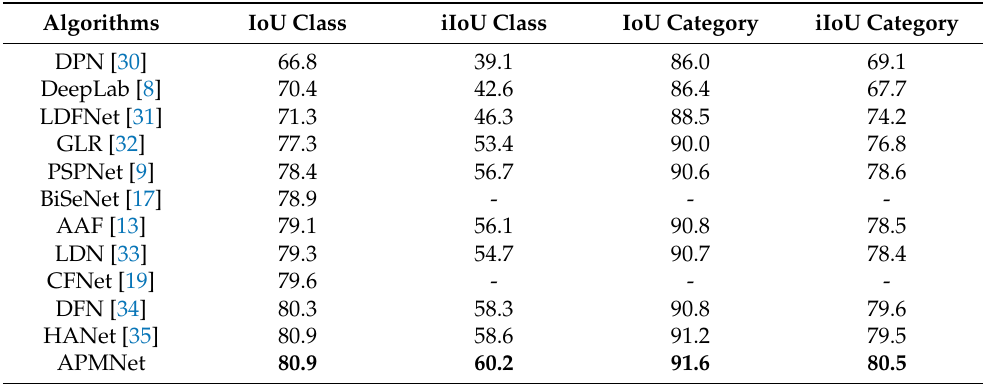
Table 5. Results with Cityscapes; “-” indicates that the results were not given in the original paper. The bold results indicate the best for the